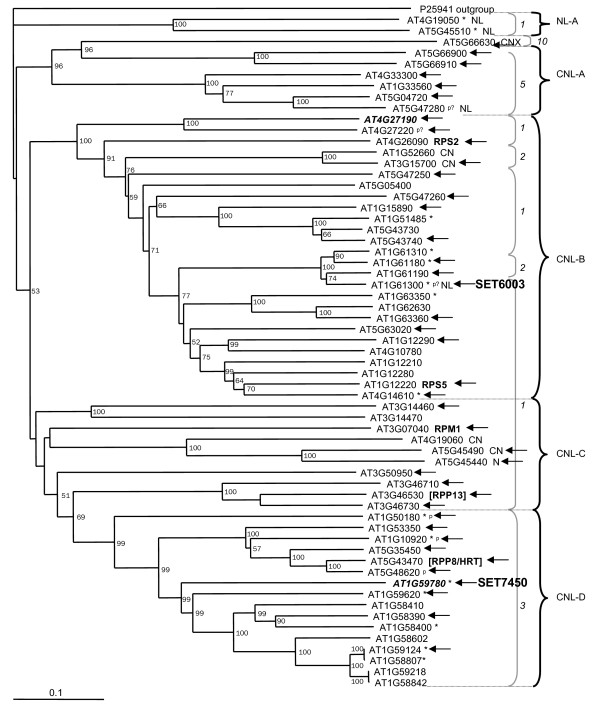
The distribution of CC-NBS-LRR-encoding and related genes analyzed on neighbor-joining tree generated by Meyers et al. [7]. The genes studied by RACE are indicated by black arrows, the genes analyzed using RT-PCR are displayed in bold italic, and NBS-LRR-encoding and related genes with enhancer trap insertions are marked in bold. Other figure denotations are as described in Meyers et al. [7].